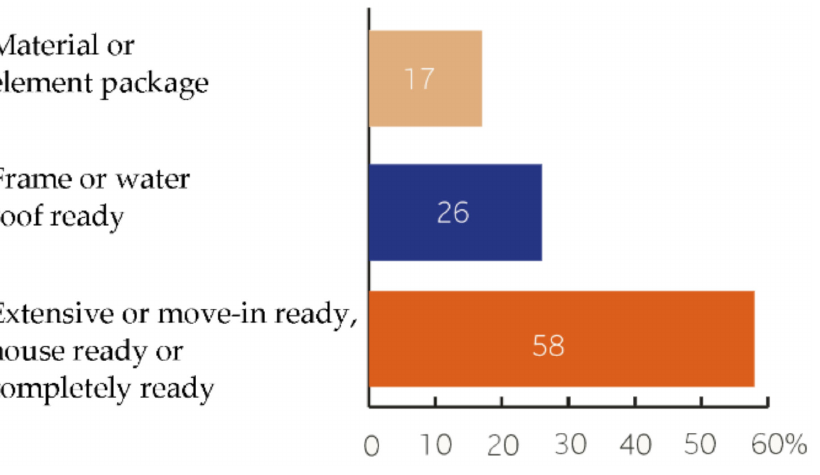
Figure 6. Small house packages sold in 2021 in Finland by delivery